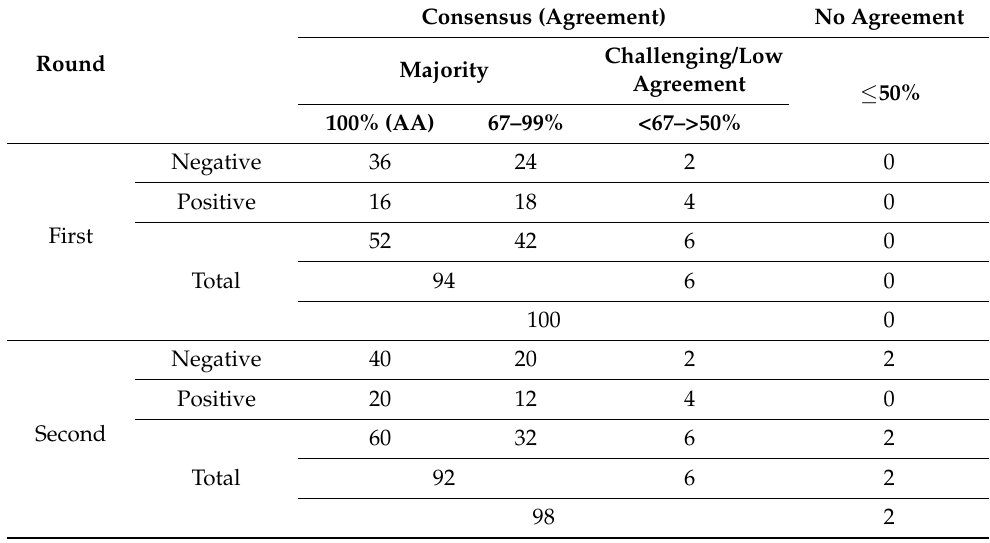
Table 3. Agreement categories in the first and second scoring rounds.